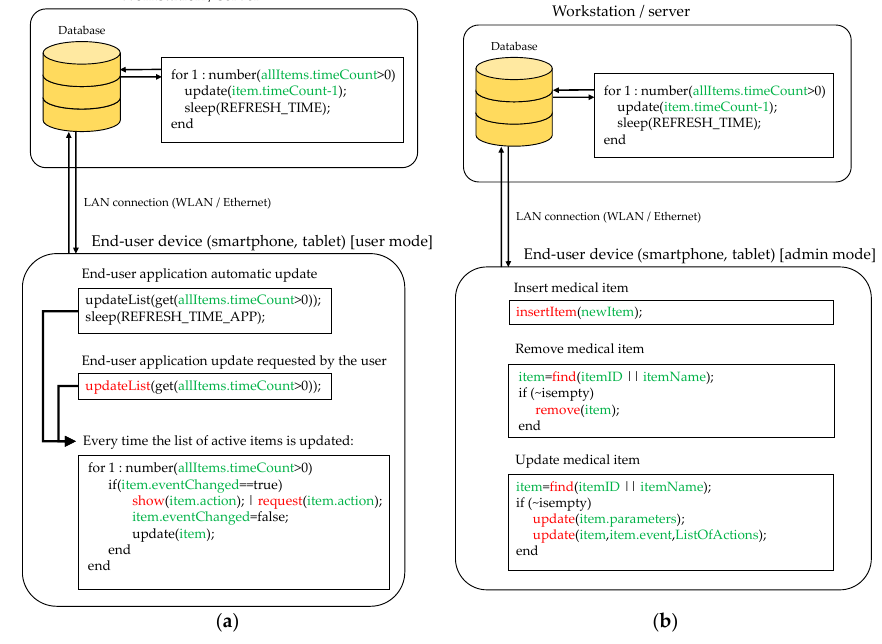
Figure 5. ( a ) Pseudo ‐ code showing the interaction between an end ‐ user and the information stored in the database. ( b ) Pseudo ‐ code illustrating how new items are introduced in the database when the user is authenticated as administrator. Information associated to the database is highlighted in green, while end ‐ user actions using the mobile application are denoted in red.